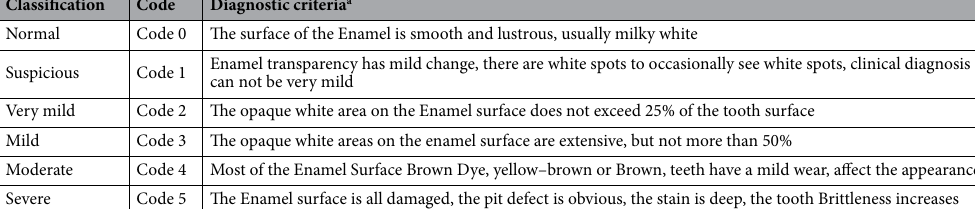
Table 1. Diagnostic criteria based on Dean’s Index. a According to the Enamel Color, luster and the area of the defect to determine the degree of damage, from a person’s dentition found the most damaged two teeth score, if two teeth damage degree is different, with the lighter one score.